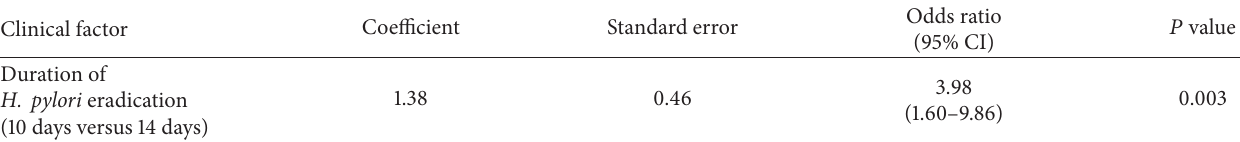
Table 5: Multivariate analysis of the clinical factors influencing the efficacy of Helicobacter pylori